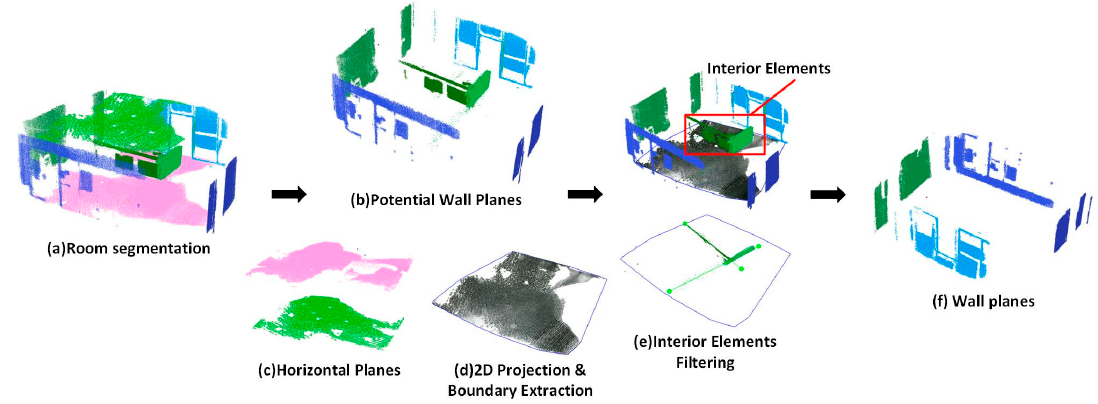
Figure 5. Sample of generation of wall candidates.